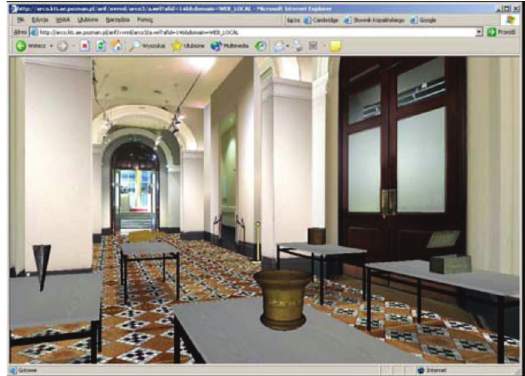
Figure 4: ARCO virtual museum exhibition [4].